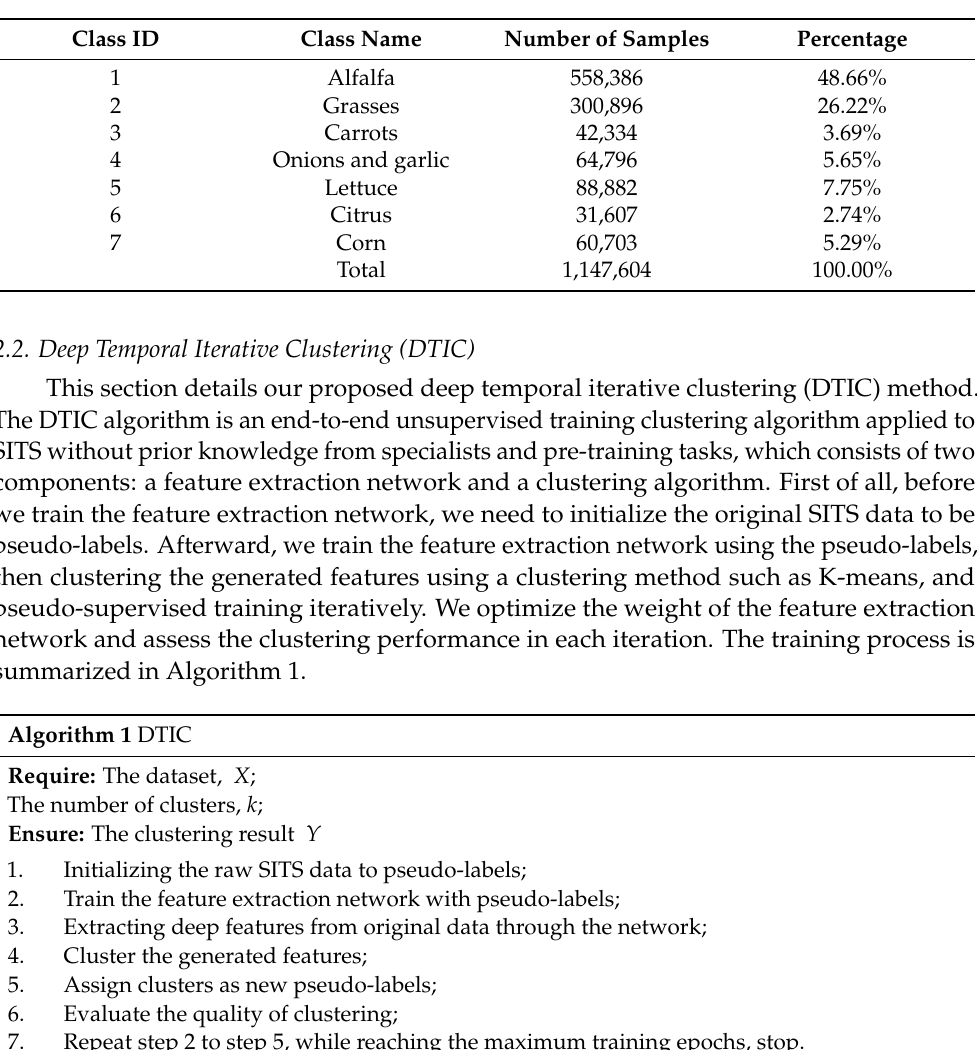
Table 2. The detailed class distribution of the Imperial